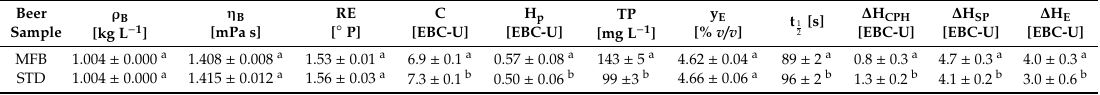
Table 3. Main chemico-physical (density, ρ B , and viscosity, η B , at 20 ◦ C; real extract, RE; color, C; permanent haze, H p ; total polyphenol content, TP; alcohol titer, y E ; beer foam half-life, t 1 (haze increase resulting from chilling, ∆ H CPH , and tannic acid, ∆ H SP , or alcohol, ∆ H E , addition,) characteristics of the beer samples micro-filtered beer (MFB) and significantly di ff erent from the same beer (STD) examined in this work.